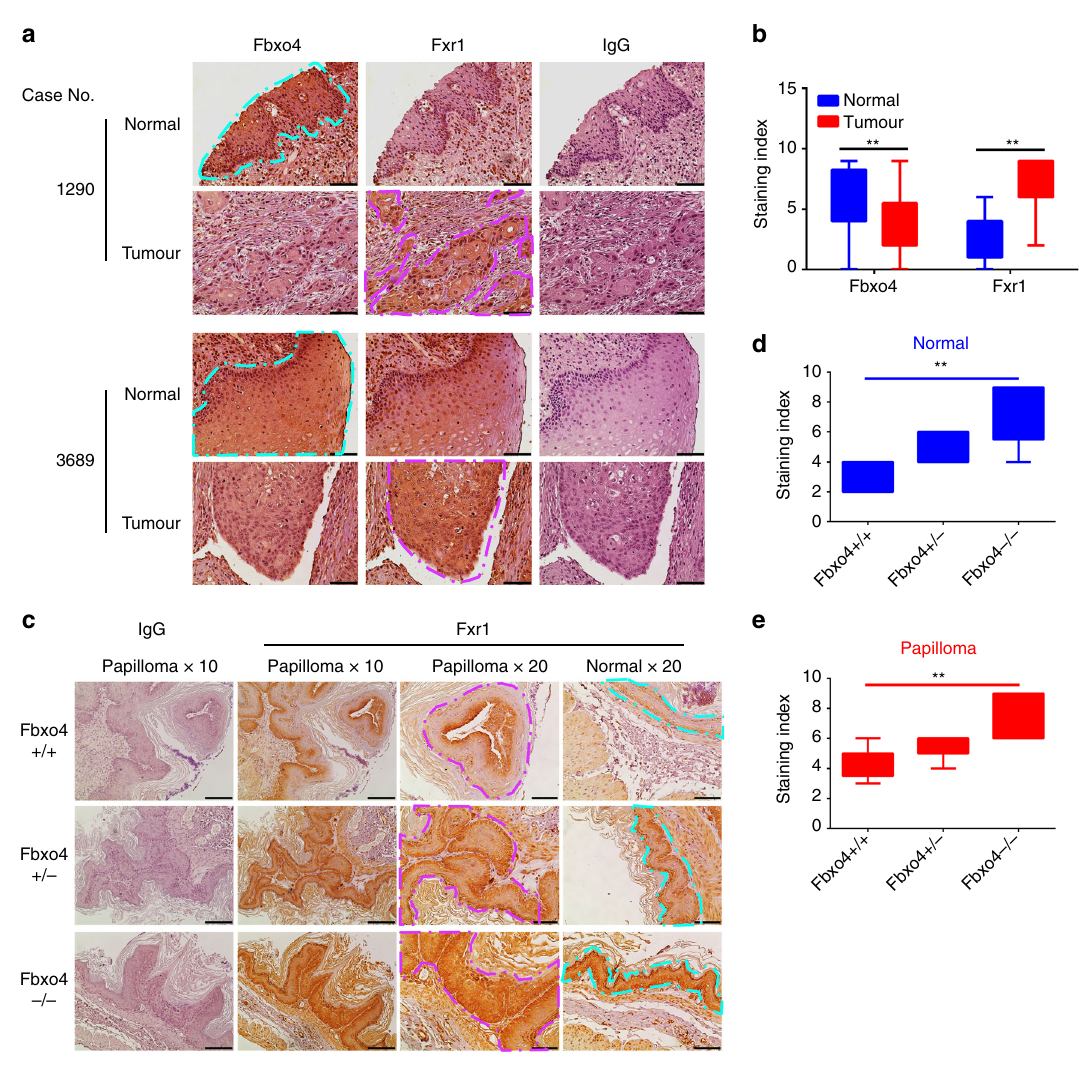
Fig. 5 Fxr1 expression reversely correlates with Fbxo4 protein levels in both human HNSCC and mouse papilloma tissues. a Representative image of Fbxo4 and Fxr1 IHC staining in human HNSCC TMAs. b Quanti fi cation and statistical analyses of the stained TMA specimens. Analysis was performed using nonparametric Mann – Whitney U test. ** p < 0.01. c Representative illustration of Fxr1 IHC staining in papilloma-induced by NMBA in transgenic mice with Fbxo4 + / + , + / − and − / − genetic background. d , e Quanti fi cation and statistical analyses of the IHC stained normal ( d ) and papilloma ( e ) sections. Analyses were performed using nonparametric Kruskal – Wallis test. ** p < 0.01. Box-and-Whisker plots: the upper and lower parts of the box show the 75th percentile and the 25th percentile, respectively; the bars outside of the box show the Min and Max values. Turquoise enclosed areas indicate normal epithelia; magenta-enclosed areas indicate either HNSCC or papilloma. Scale bar, 10 μ